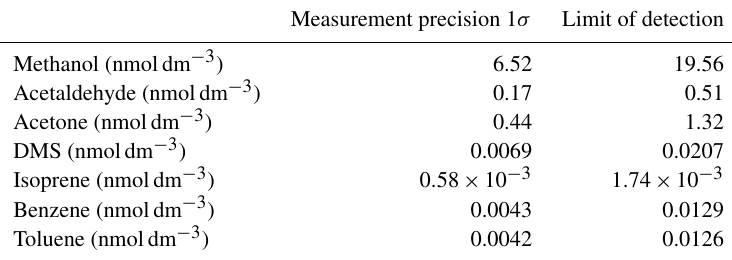
Figure 3. Invasion calibration curves for benzene (a) , toluene (b) , DMS (c) , and isoprene (d) for which a known amount of standard gas is added to the zero air carrier gas while measuring VOC-free Milli-Q water. Error bars were too small to display, but the noise associated with the measurement was found to be 0.0069 and 0.00058ppbv for DMS and isoprene, respectively, and 0.043 and 0.042ppbv for benzene and toluene, respectively. This was calculated as the SD of 10 consecutive water blank measurements. A 1 : 1 line is included to illustrate the role of the water phase in absorbing these compounds. Table 2. Analytical precision and limit of detection of the seawater VOC